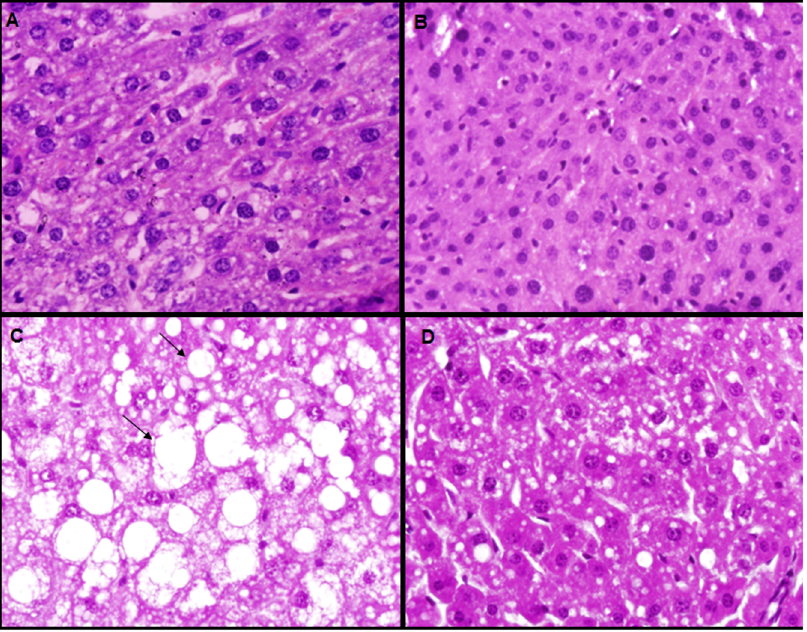
Fig 4. Photomicrographs of the liver structure. Sections of the liver were stained with hematoxylin and eosin, and each photomicrograph is shown at the same magnification. (A) The usual liver appearance in the control group; (B) ASE did not change the liver appearance; (C) macro- and micro-vesicular steatosis in the HF group; (D) steatosis was reduced in the HF+ASE